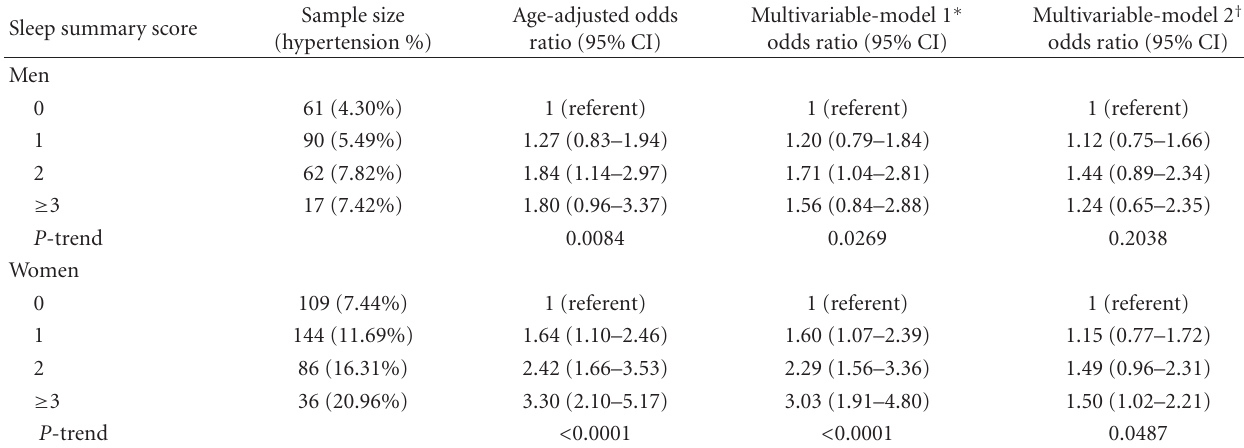
Table 3: Association between sleep variables and C-reactive protein levels > 1mg/dL, by gender.